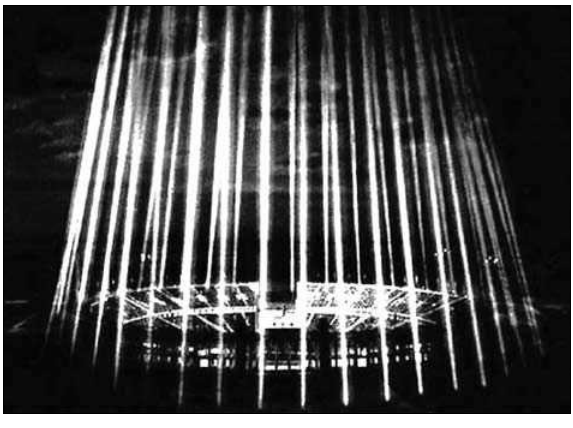
Fig. 13. ceremony of Olympic